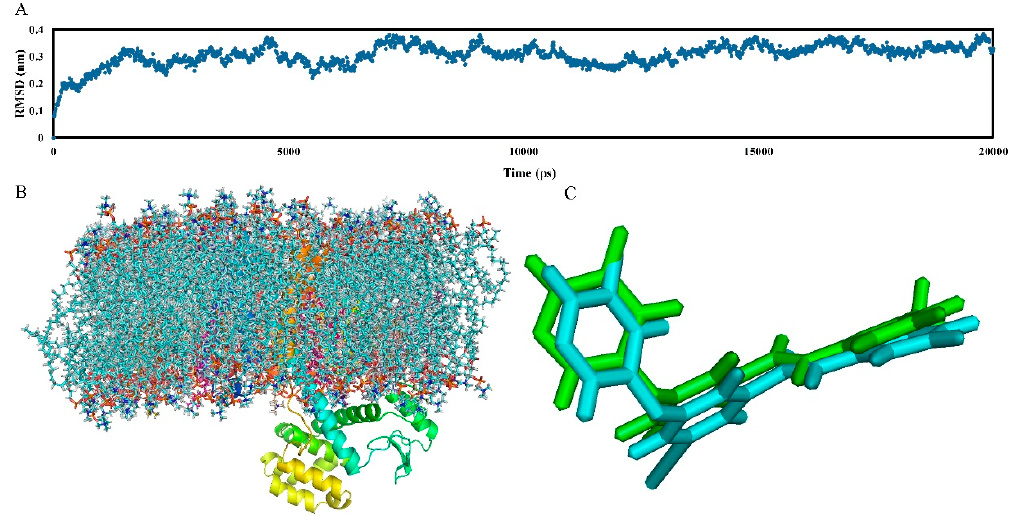
Figure 6. ( A ) Time evolution of the root mean square deviation (RMSD) of the skeletal atom from the initial docking structure during the 20,000 ps molecular dynamic (MD) simulation; ( B ) the structure of the receptor with the docked ligand within the lipid bilayer at the last 1 ns of MD stimulation. Protein, ligand, and lipid molecules are shown as ribbons, lines, and spheres, respectively; ( C ) superposition of the MD structure at the last 1 ns (blue) and initial structure of the docked compound 74 (green).